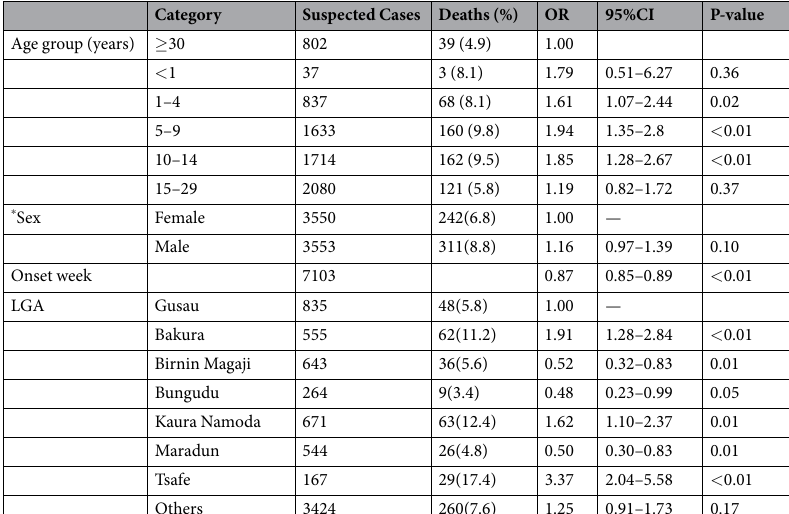
Table 2. Factors associated with mortality among suspected meningitis cases in Zamfara state. * Sex was included in the logistic regression model as a potential confounder with females as the reference. The reference for LGAs in the model was Gusau, the state Zamfara state capital. The reference for age group was adults > 30 years